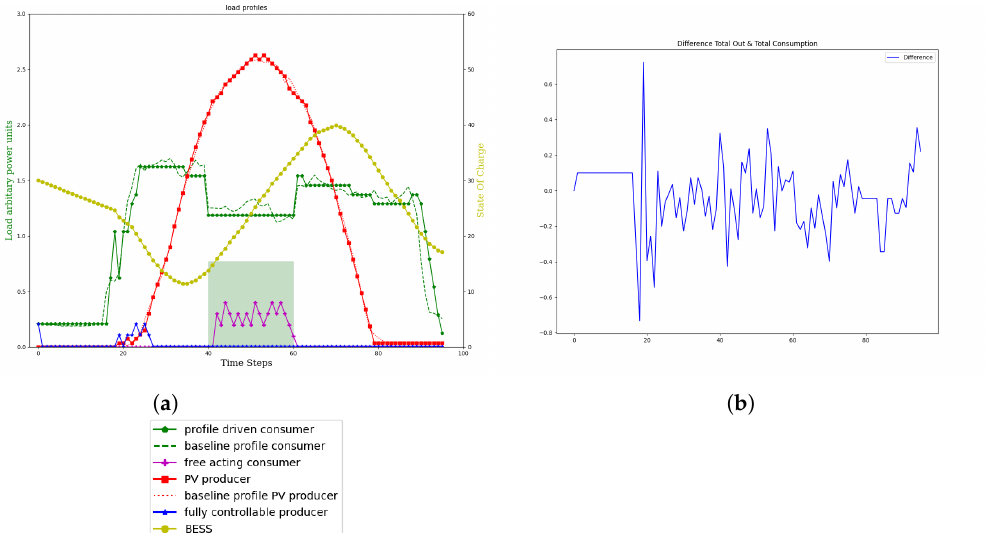
Figure 18. Evaluation of stress on day 1 (generalised), with consumer agent stressed moderately. ( a ) Agent load curves and profiles. ( b ) Load balancing